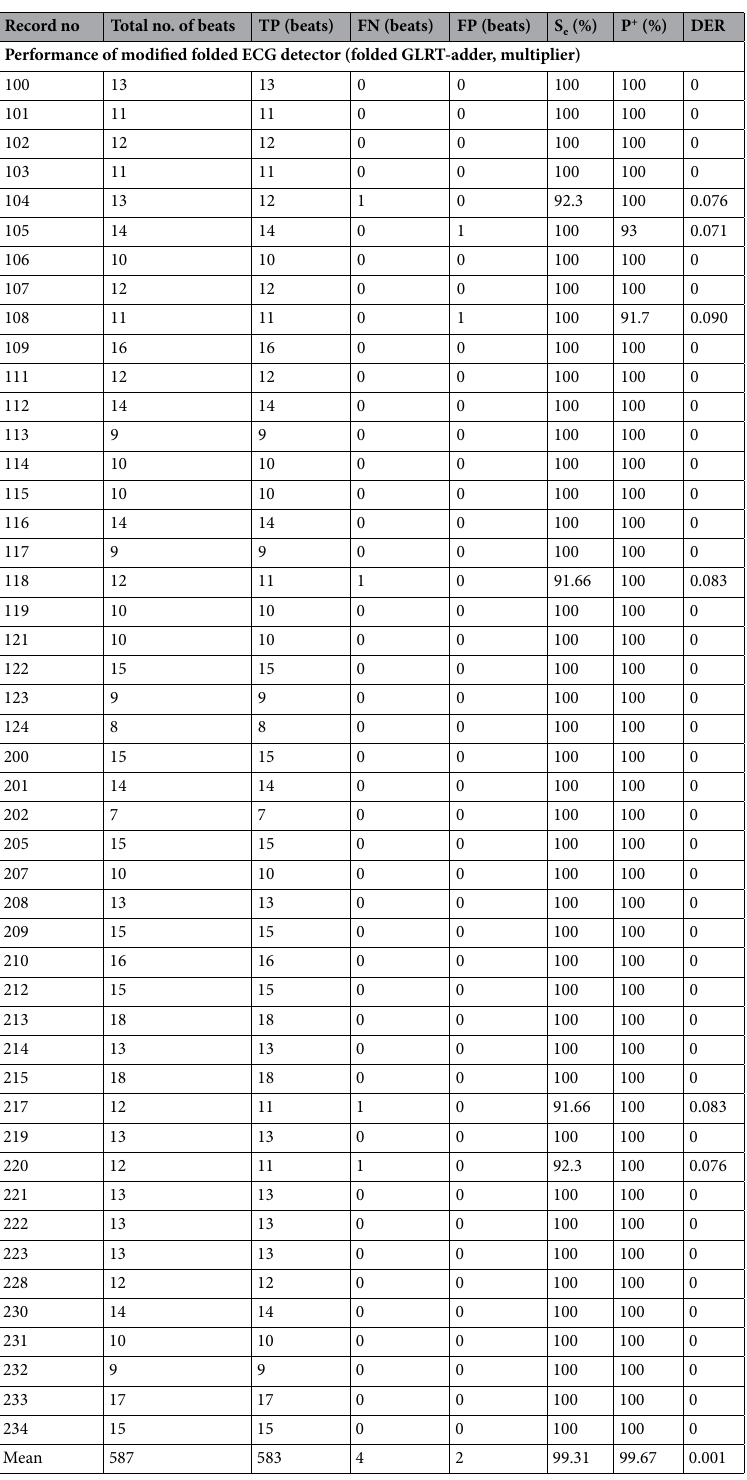
Table 3. Performance of modified folded ECG detector with short term